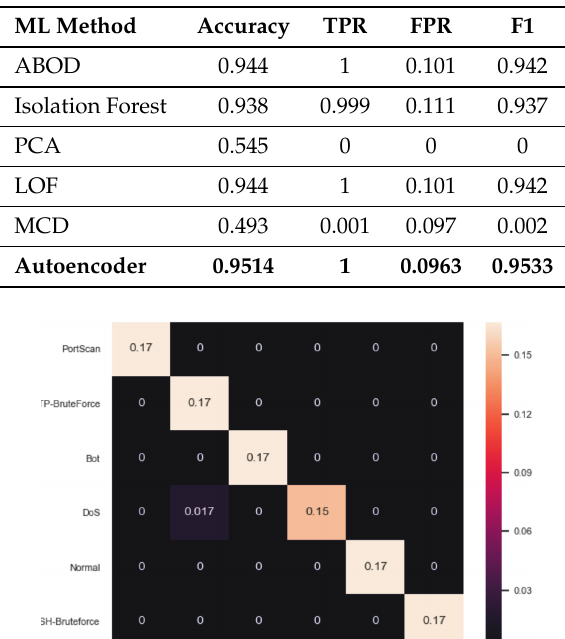
Table 2. Evaluation Results of the First ARIES Detection layer—ADM.